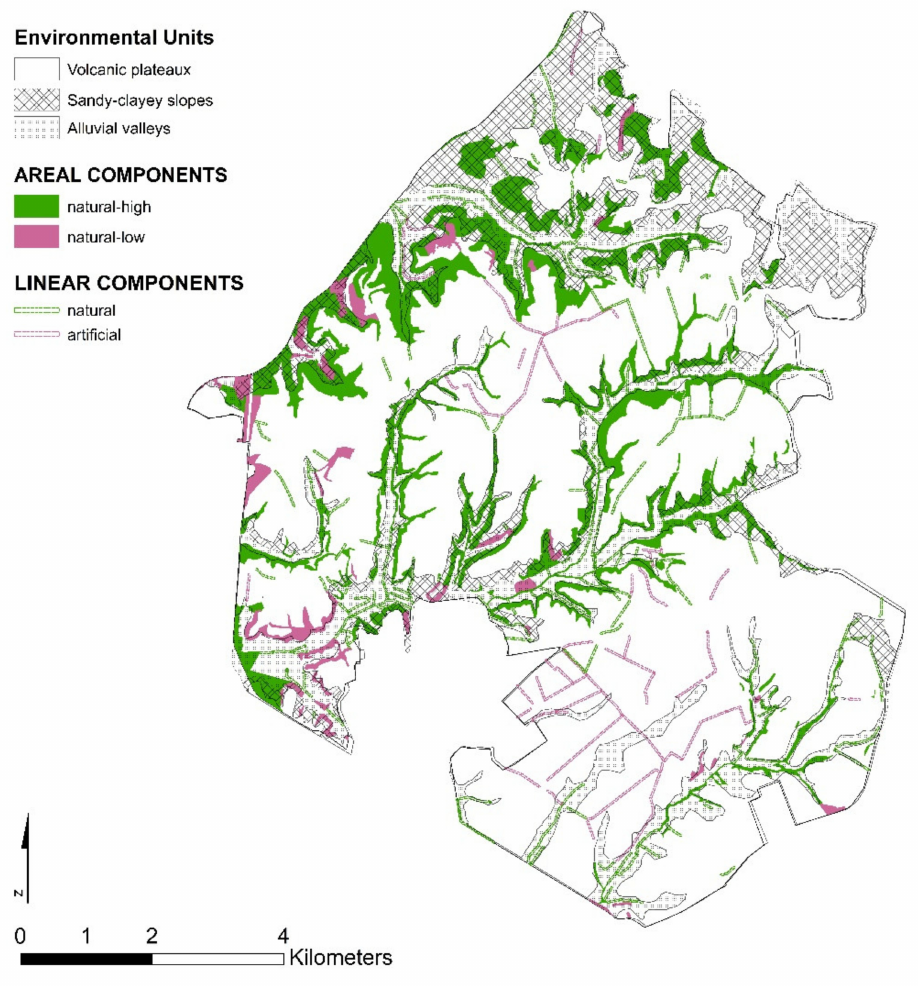
Figure 5. Spatial arrangement of suitable GI components in the environmental units of the Marcigliana Nature Reserve, distinguished according to structural features (areal or linear extent) and degree of